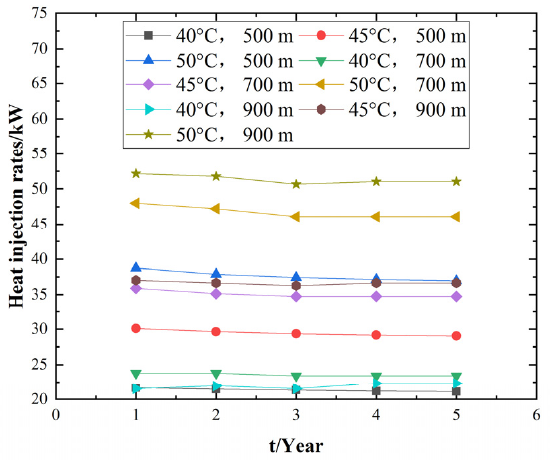
Figure 12. Heat injection rates of the novel DBHE system at different depths of the check valve.